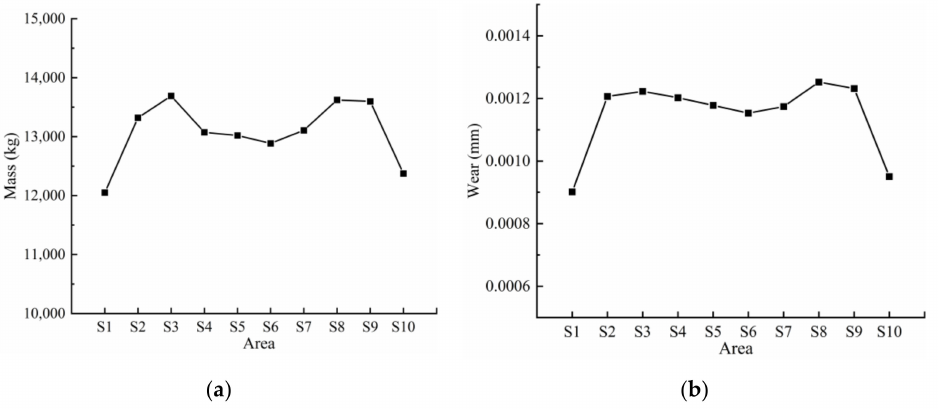
Figure 5. ( a ) The total mass of particles in each area in the simulation at 60 s. ( b ) The average cumulative wear of each area in the simulation at 60